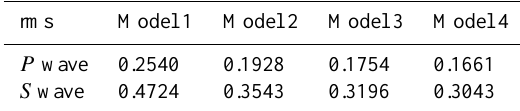
Table 3. The root mean square (rms) values of P wave and S wave travel-time residuals in iteratively updated